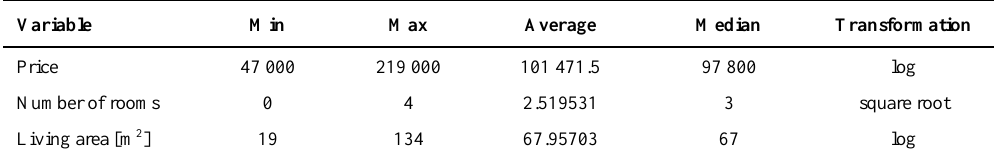
Table 3. Descriptive statistics for quantitative variables.